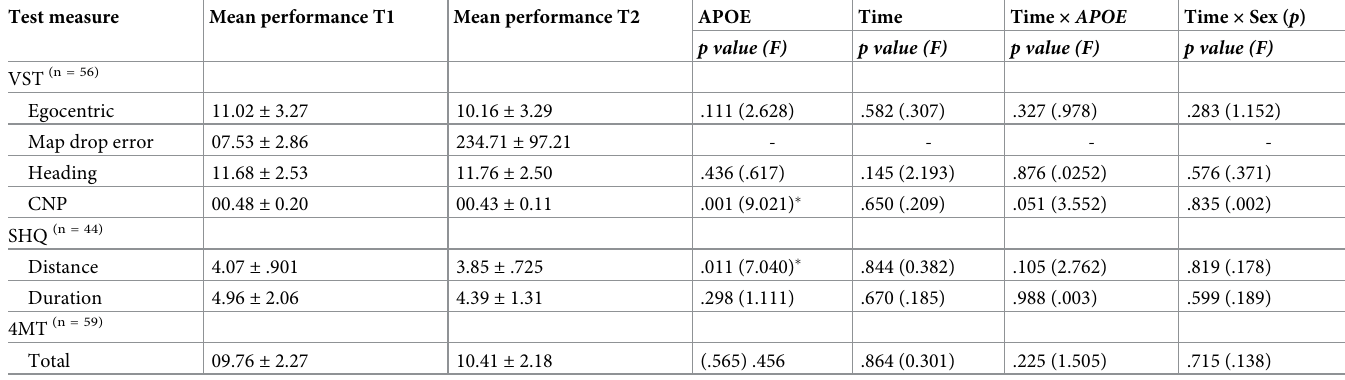
Table 4. Mean scores and practice effects on the Virtual Supermarket test, Sea Hero Quest and the Four Mountains test. Test measure